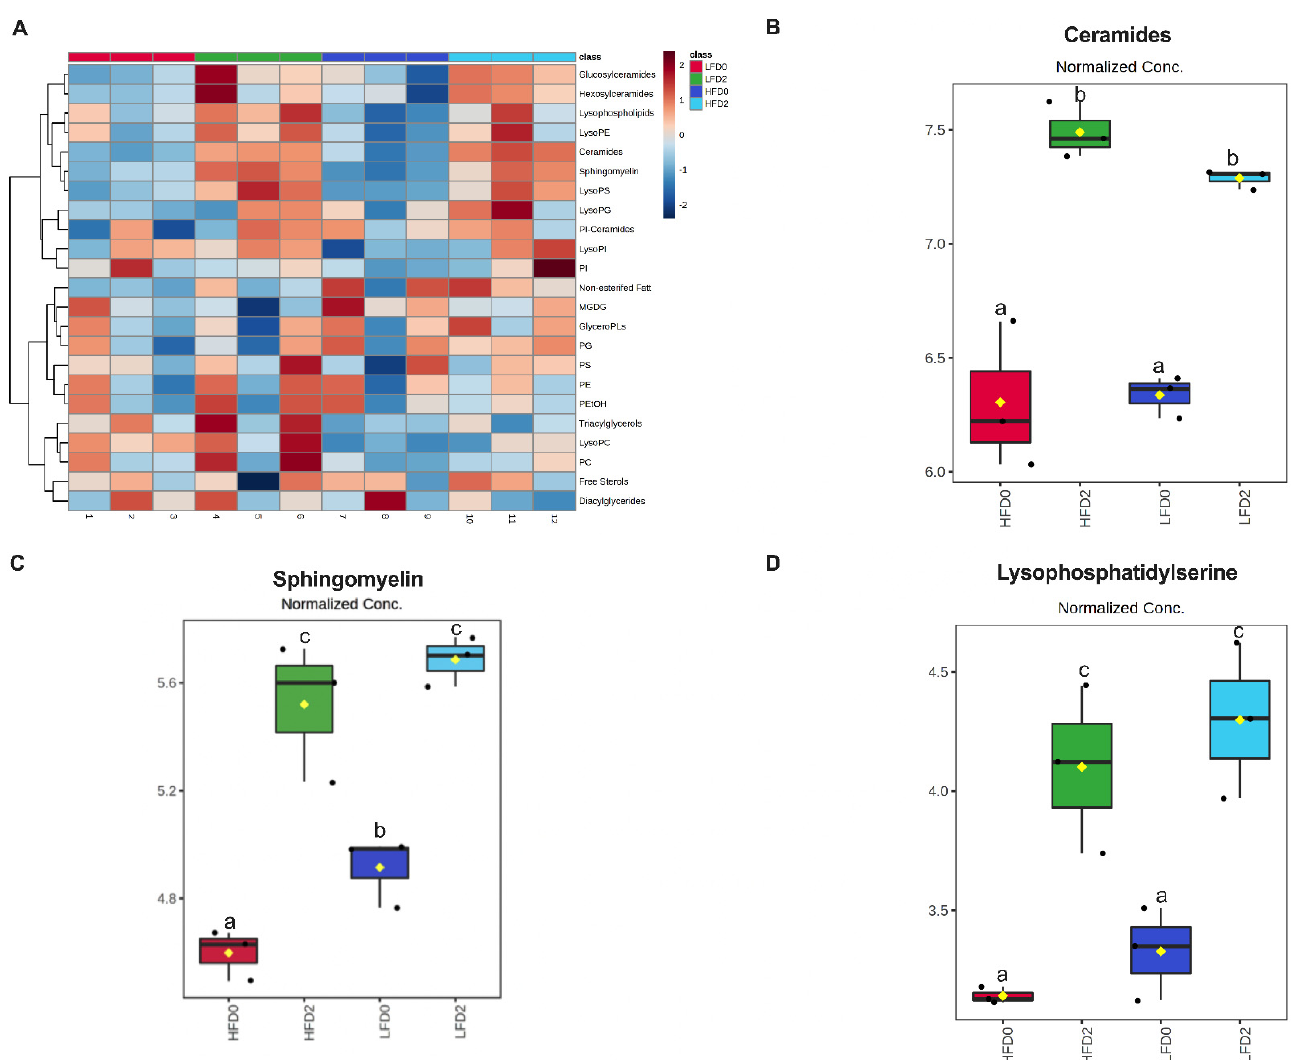
Figure 6. MPLs increase fecal phospholipid and sphingolipid metabolites in male mice. A heatmap of the sum of lipid classes ( A ) and total ceramides ( B ), sphingomyelin ( C ), and lysophosphatidylserines ( D ). Data were normalized using log transformation and were analyzed using a one-way ANOVA with false discovery rate FDR q-value < 0.05 (n = 3/group). Values with unlike letters indicate differences at p <0.05 using post-hoc comparisons. Abbreviations: LysoPE, lysophosphatidylethanolamine; LysoPS, lysophosphatidylserines; LysoPG, lysophosphatidylglycerol; PI-Ceramides, phosphatidylinositol-cermamides; LysoPI, lysophosphatidylinositol; PI, phosphatidyli- nositol; MGDG; Monogalactosyldiacylglycerols; GlyeroPLs, glycerophospholipids; PG, phosphatidyl- glycerol; PS, phosphatidylserine; PE, phosphatidylethanolamine; PEtOH, phosphatidylethanol; LysoPC, lysophosphatidylcholine; PC,